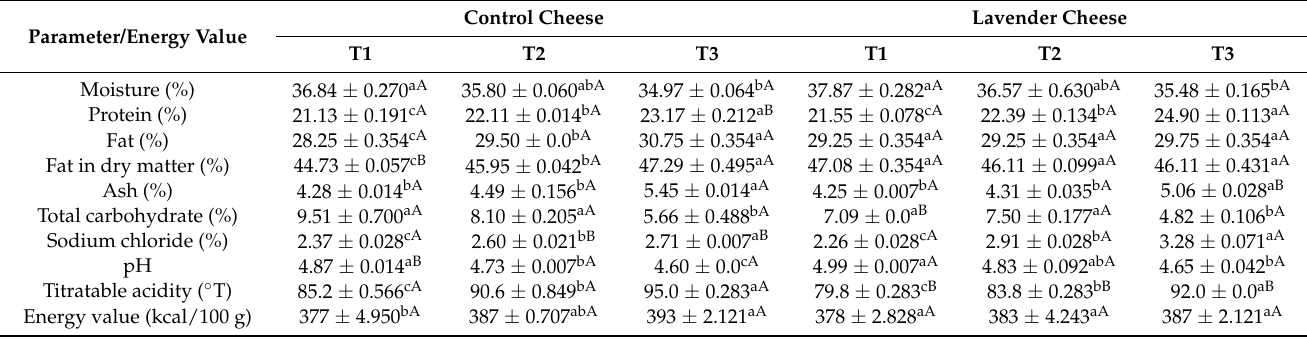
Table 1. Proximate chemical composition, sodium chloride content, pH, titratable acidity, and energy value of control and lavender Gouda-type cheese at different ripening times (T1, T2, and T3). Control